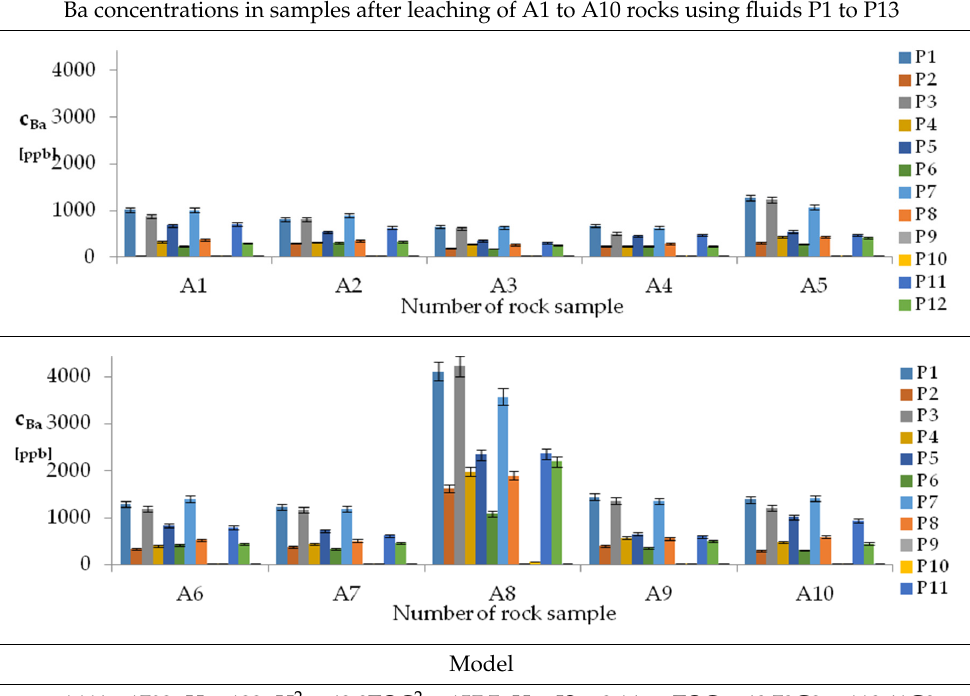
Table 6. Results of leaching samples A1 to A10 rocks using fluids P1 to P13 for Barium (Ba). Ba concentrations in samples after leaching of A1 to A10 rocks using fluids P1 to P13